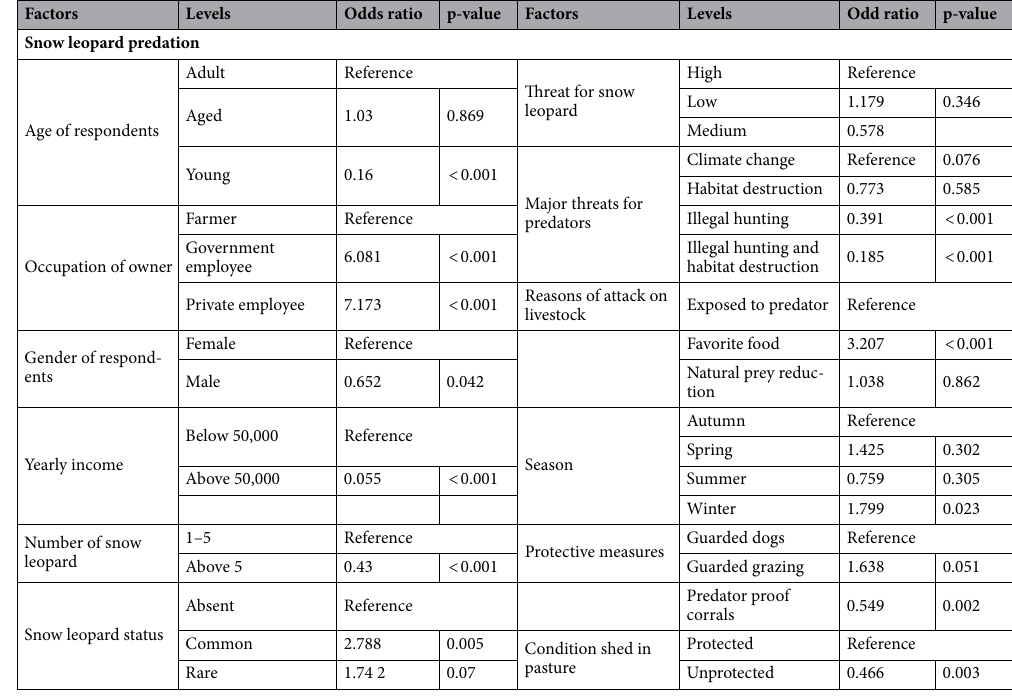
Table 3. Snow leopard predation in relation to various socio-ecological factors in Misgar valley, district Hunza.